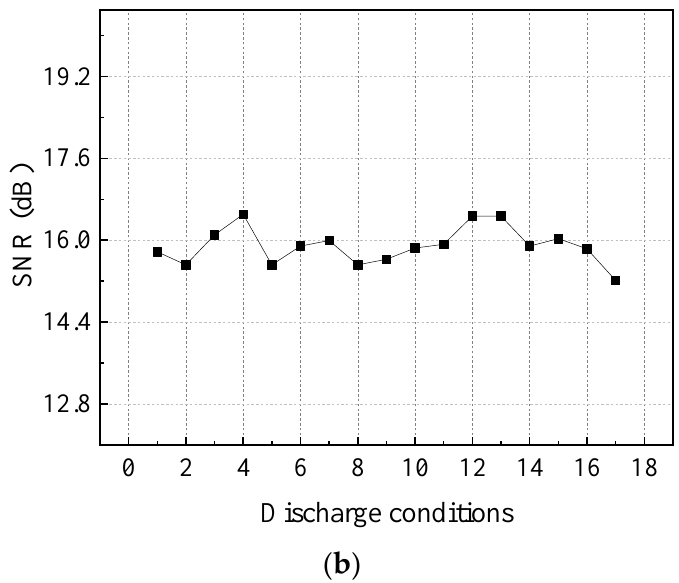
Figure 16. RMS of displacement before and after filtering ( a ) and its SNR ( b ) of signal at T9.